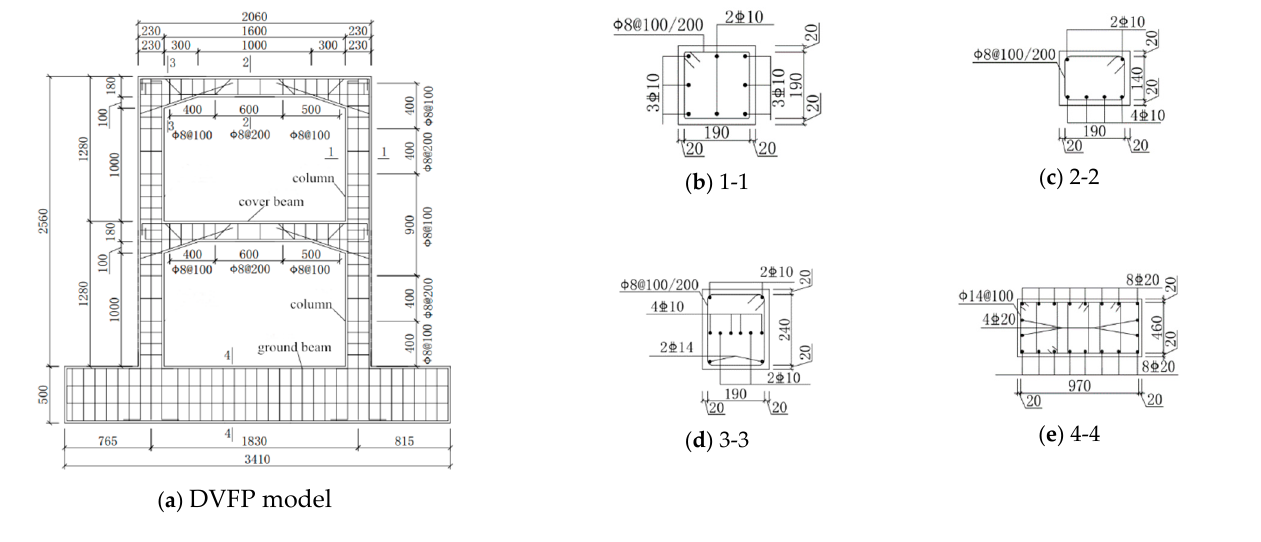
Figure 1. Details of DVFP specimen. Table 2. Material properties of CFRP and mucilage. Table 1. Material properties test results of steel.